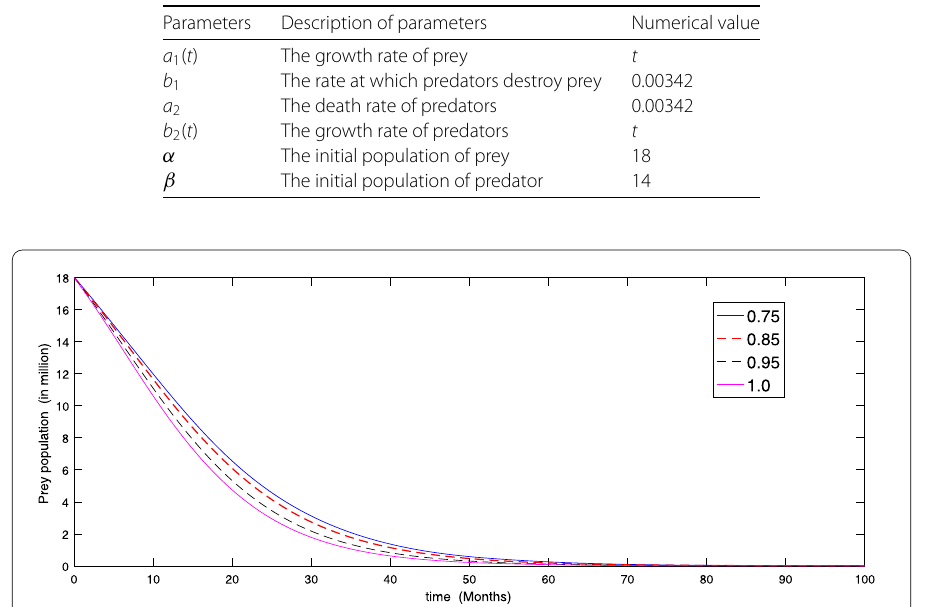
Table 2 Values of parameters taken for Case II